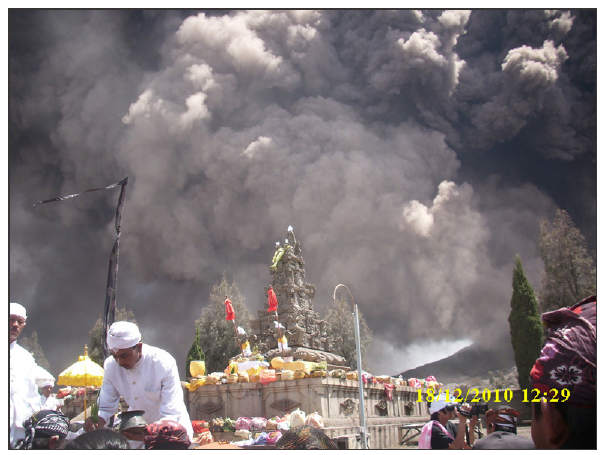
Figure 6. Religious ceremony at Puten temple inside the Tengger Caldera during the eruptions (Photo by Triono,